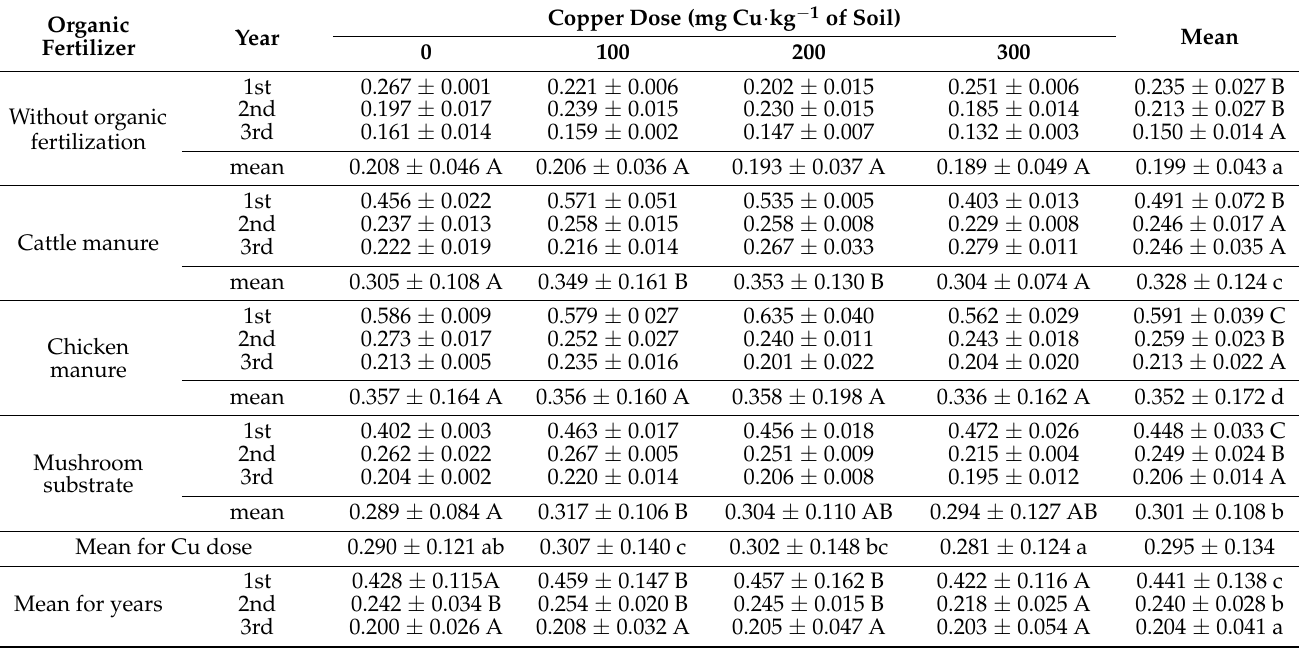
Table 3. Nitrogen uptake by cocksfoot, g N · pot − 1 (mean ±